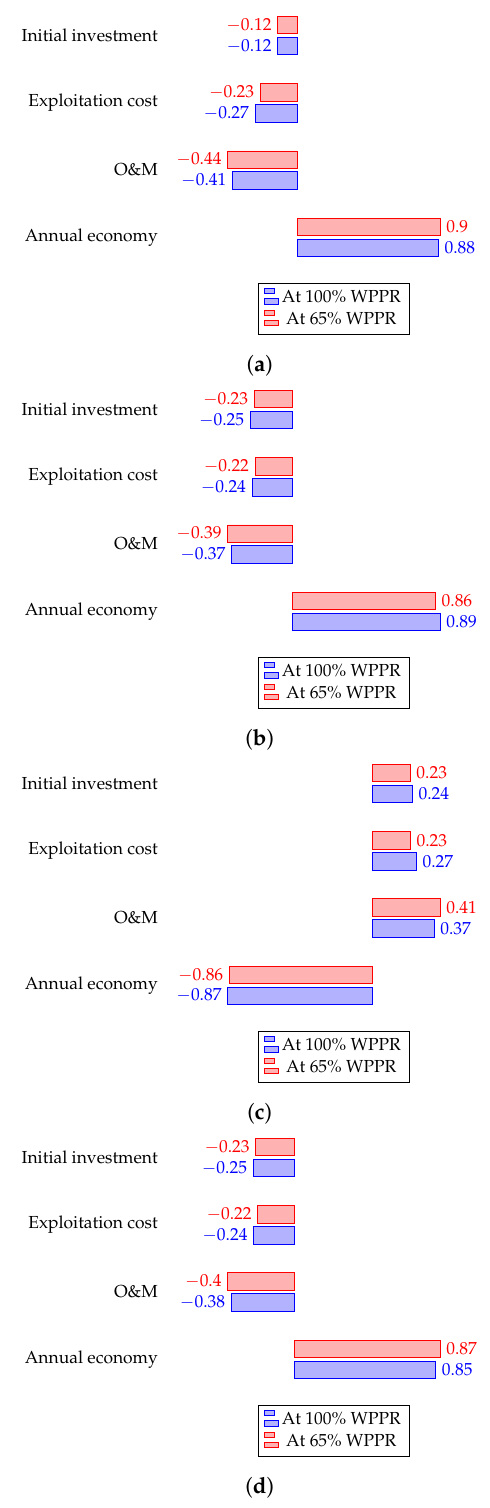
Figure 6. Financial indicator impact diagram: ( a ) net present value; ( b ) internal rate of return; ( c ) payback period; ( d ) profitability